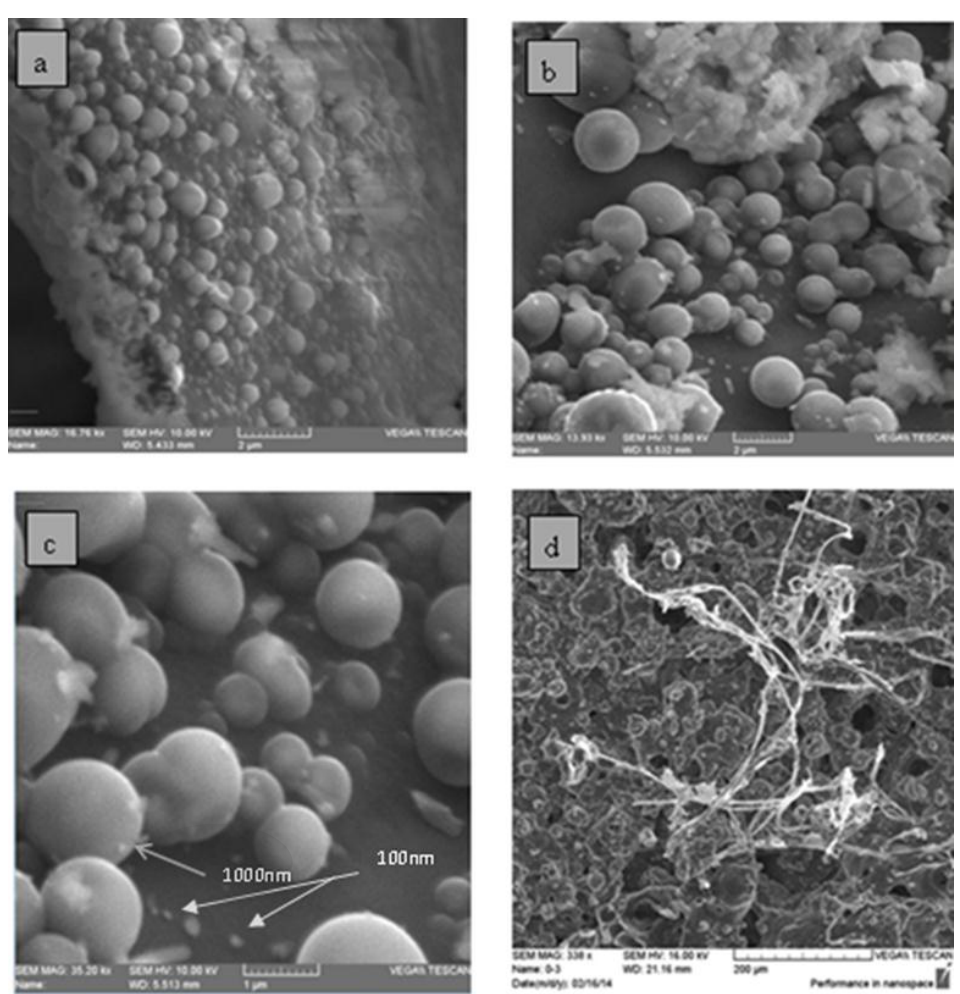
Fig. 5: Electron microscopic images of synthesized CNSs a, b, c 800 o C with different scale bar and d-reacted catalyst as CNTs with 700 o